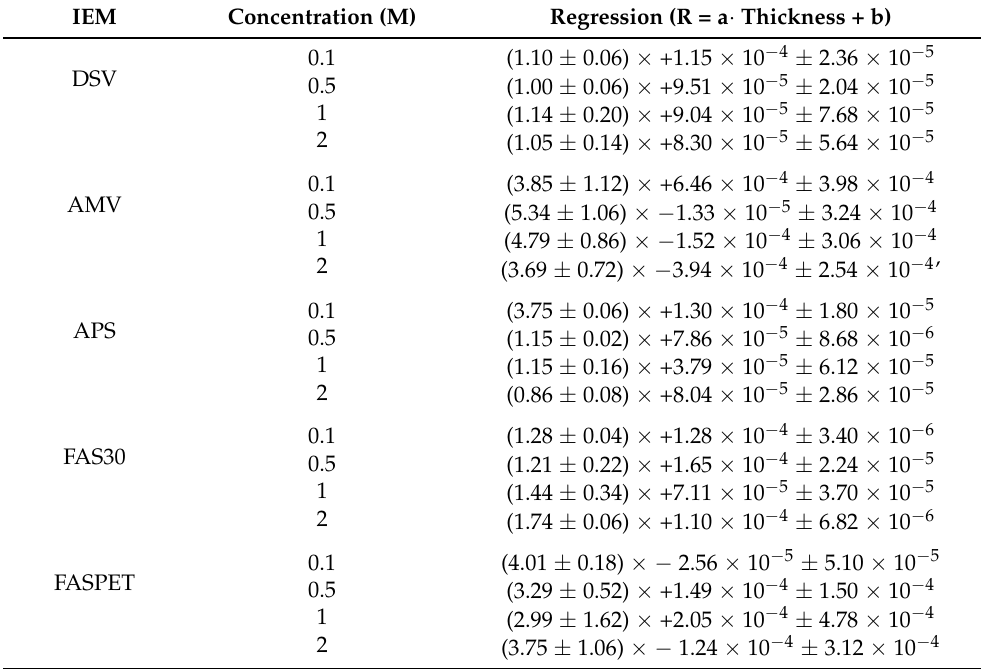
Table A3. AEMs at 313 K.